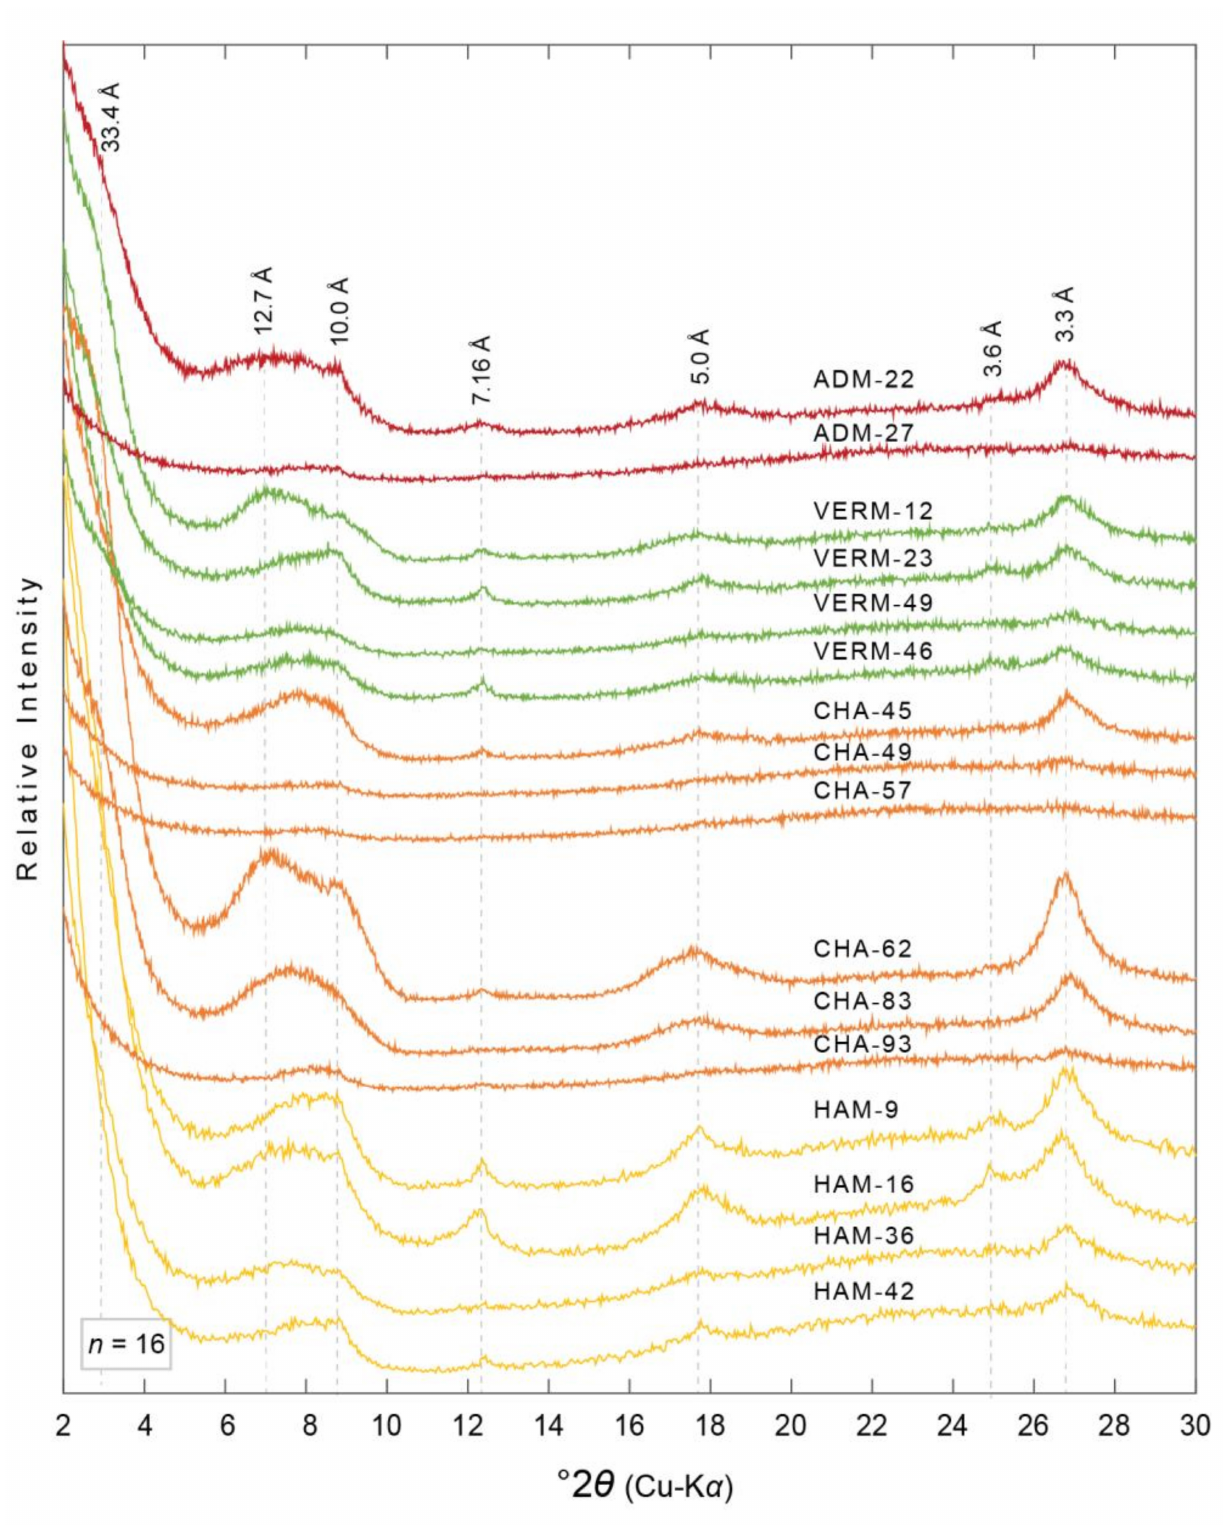
Figure 7. XRD patterns of ethylene glycol saturated oriented aggregates of the <0.2 µ m equivalent spherical diameter clay-sized fraction from select paleosols in the ADM, VERM, CHA, and HAM cores. Diffraction patterns are organized with respect to their relative stratigraphic position, i.e., HAM-40 and HAM-4 are stratigraphically the lowest and highest samples, respectively, from the HAM core. D-spacing information for minerals discussed herein are noted vertically and in angstroms (Å). Diffraction patterns are colored to correspond to core, i.e., red = ADM, green = VERM, orange = CHA, yellow = HAM. Core location noted in Figure 2. See Tables 1 and 3 for more